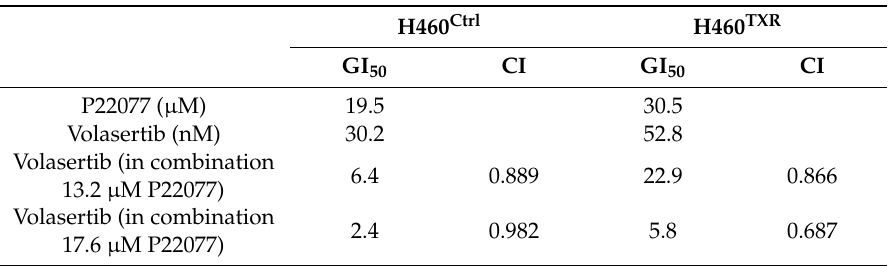
Table 1. The half maximal growth inhibitory concentration (GI 50 ) values for P22077 and volasertib and their combination index (CI) in H460 and H460TXR cells. CI < 1 represents synergism, CI = 1 represents additive e ff ect, CI > 1 represents